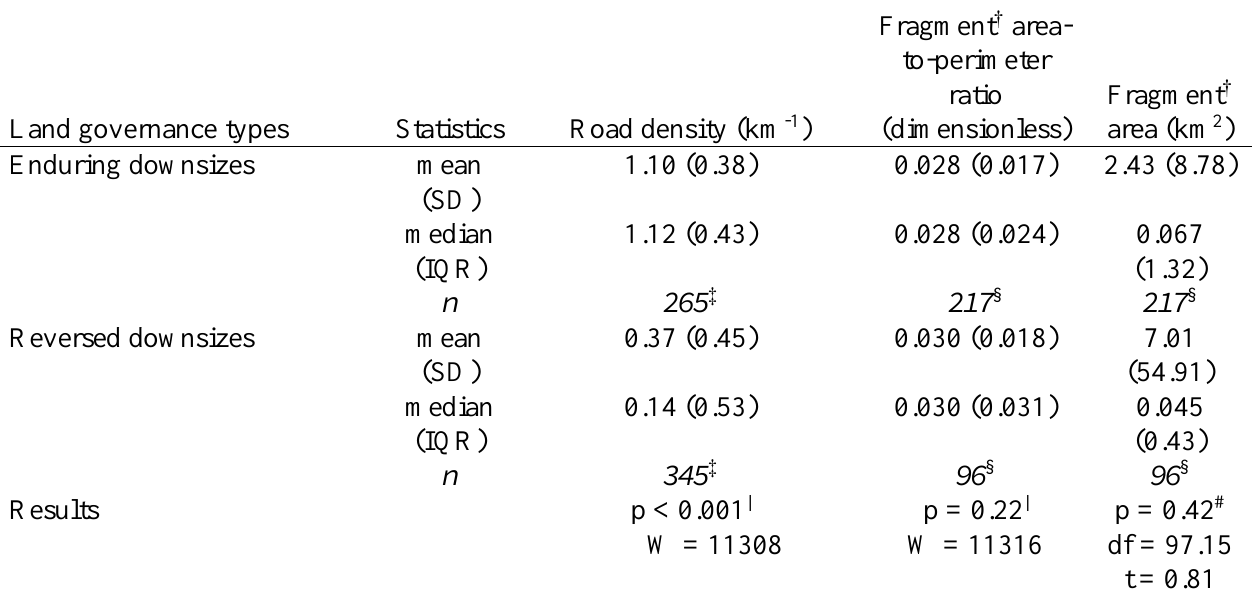
Table A1.9: Habitat fragmentation indicators in enduring and reversed downsizes for all land cover